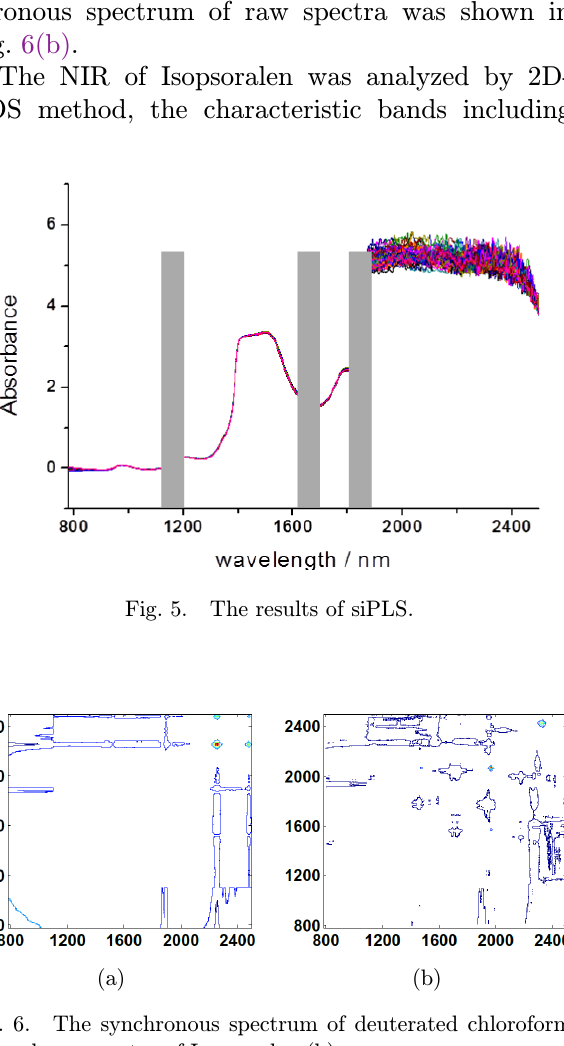
Fig. 7. PRESS plot of NIR by di®erent